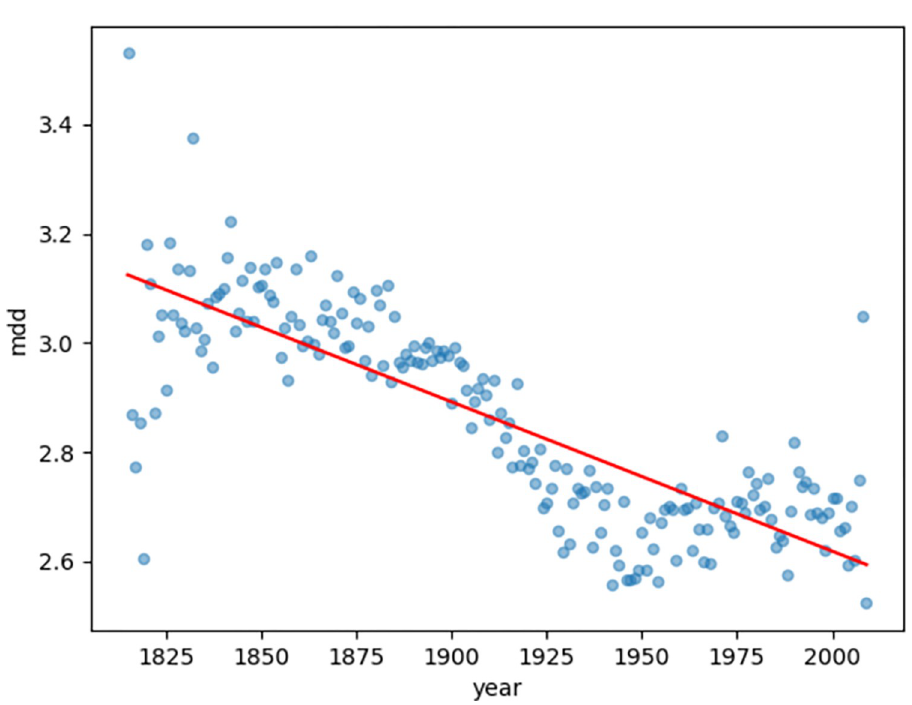
Fig 2. Diachronic linear distribution of MDD for magazine texts.